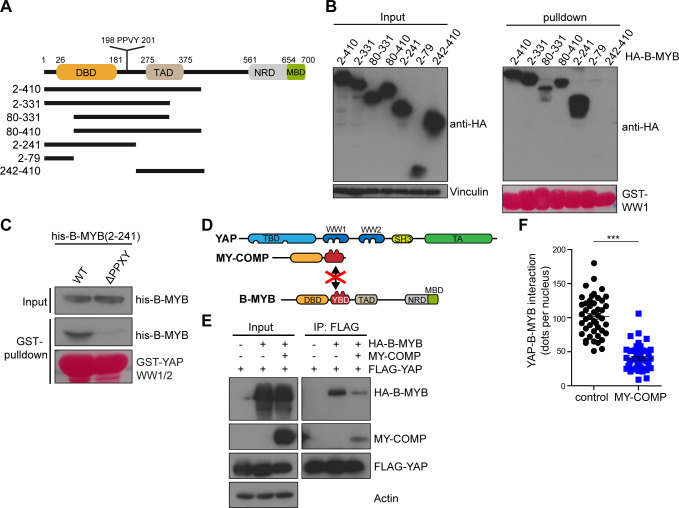
Disrupting the association between B-MYB and YAP by MY-COMP.A) Scheme of the domain structure of B-MYB and deletion constructs. B) Pulldown experiments with GST-WW1 and HA-tagged B-MYB constructs. Bound proteins were detected by immunoblotting with a HA antibody. Input: 3% of the lysate. Vinculin was used as a control. Recombinant GST-proteins were detected by Ponceau staining. C) Pulldown experiments with GST-WW and his-tagged B-MYB(2–241) and B-MYB(2–241,ΔPPXY). Bound B-MYB was detected with a his-antibody. Input: 3% of the recombinant his-tagged B-MYB constructs. Recombinant proteins were detected by Ponceau S staining. D) Scheme for the disruption of the YAP-B-MYB interaction by MY-COMP. E) HeLa cells were transfected with flag-YAP, HA-B-MYB and MY-COMP (HA-NLS-B-MYB(2–241)) as indicated. Flag-YAP was immunoprecipitation and bound HA-B-MYB was detected by immunoblotting. When MY-COMP was co-transfected, the interaction between flag-YAP and HA-B-MYB was decreased. Input: 3% of the lysate. A quantification is shown in Suppl. S6C Fig. F) PLA of endogenous YAP and B-MYB upon transfection of MY-COMP showing that the MY-COMP disrupts the interaction between YAP and B-MYB. Example microphotographs are shown in S6D Fig. Error bars indicate SEMs. Student’s t-test. *** = p<0.001.